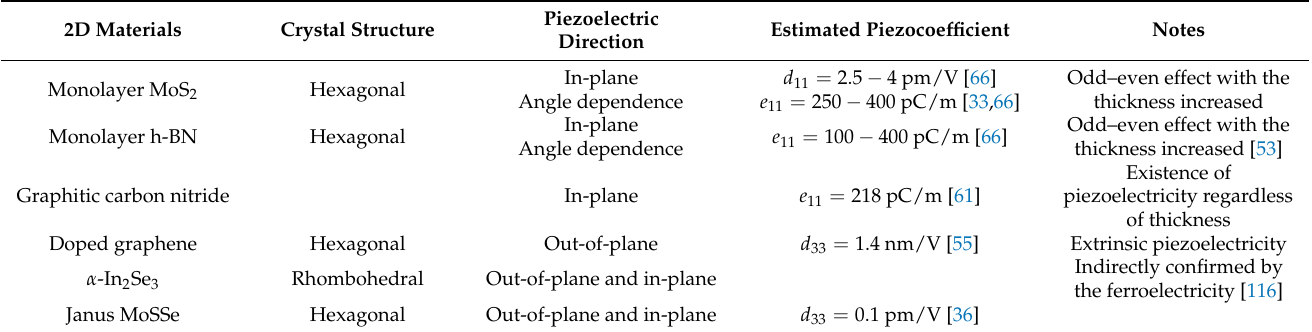
Figure 11. ( a , b ) The piezoelectric coefficients of some common two-dimensional (2D) materials [54]. Reproduced with permission from [54]. Copyright 2018, Springer Nature. Table 3. Relevant information of the experimentally confirmed piezoelectric 2D materials [54]. Reproduced with permission from [54]. Copyright 2018, Springer Nature.